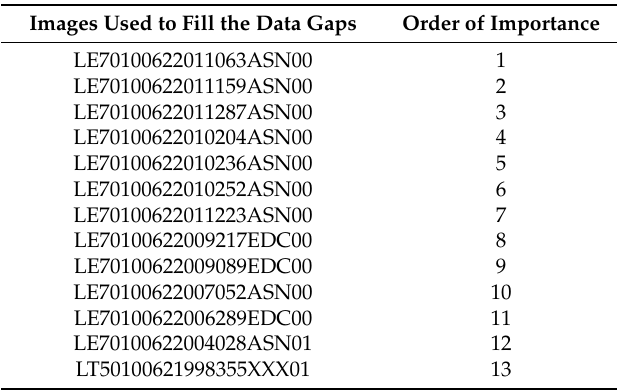
Table 1. The images used to fill data gaps and its order of importance.